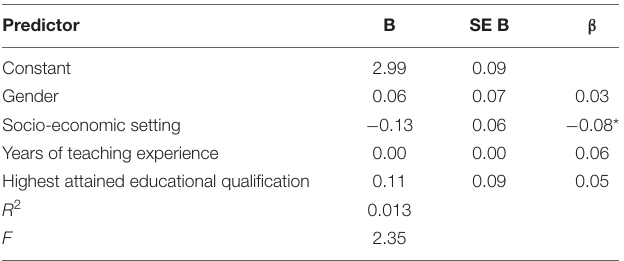
TABLE 4 | Multiple regression analysis predicting the Stability of Mathematical Knowledge belief from gender, socio-economic setting, years of teaching experience and highest attained education qualification.